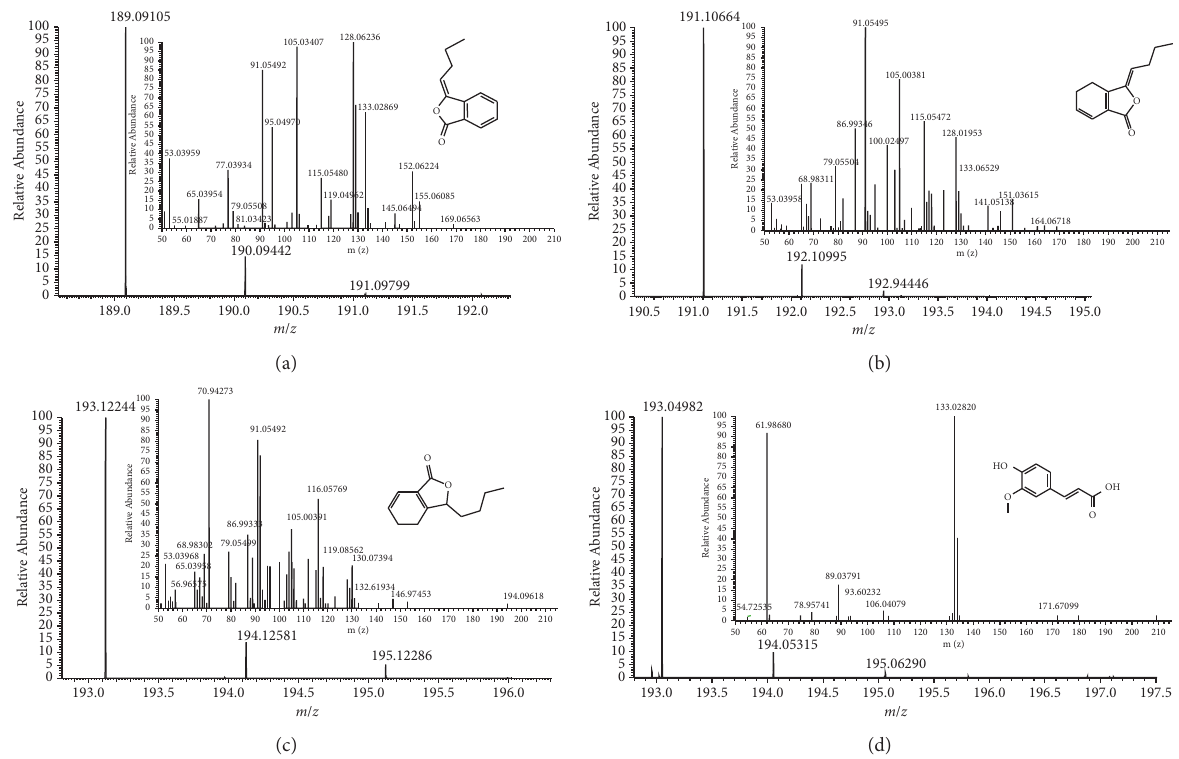
Figure 1: The mass spectra of molecular ions and fragmentation of butylidenephthalide (a), ligustilide (b), senkyunolide A (c), and ferulic acid (d).